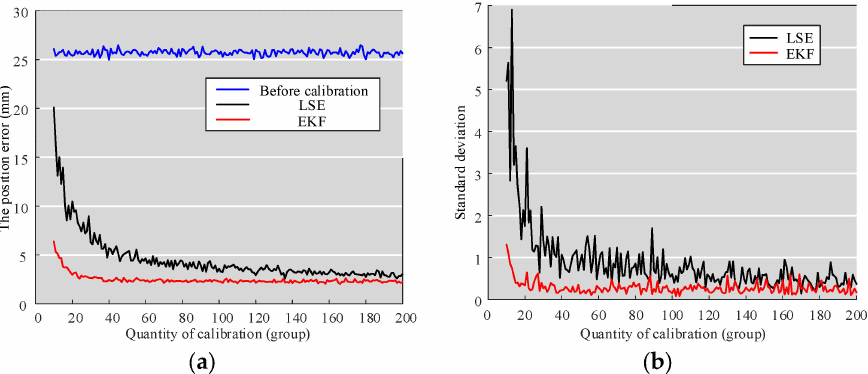
Figure 8. Calibration effect with different numbers of experimental configurations. ( a ) change in the position error; and ( b ) change in the standard